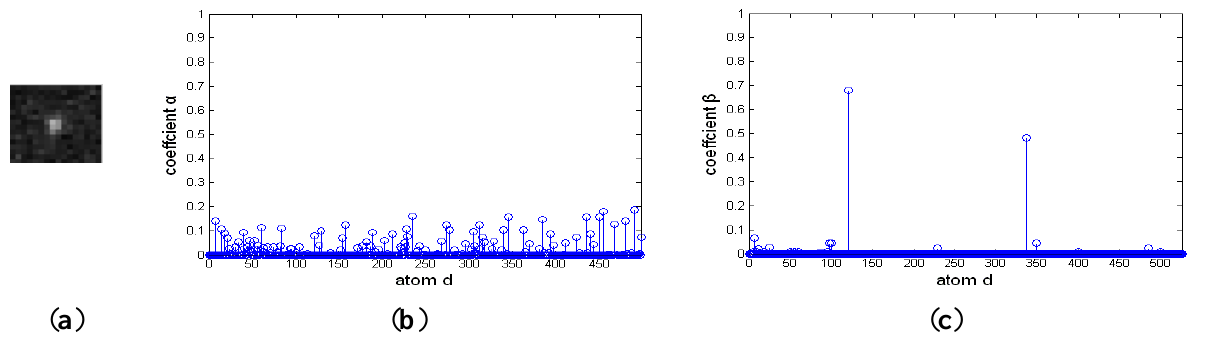
Figure 13. Representation coefficient of target signal in multi-target image decomposed on discriminative over-complete dictionary. ( a ) Target signal. ( b ) Sparse coefficient on background dictionary. ( c ) Sparse coefficient on target dictionary.